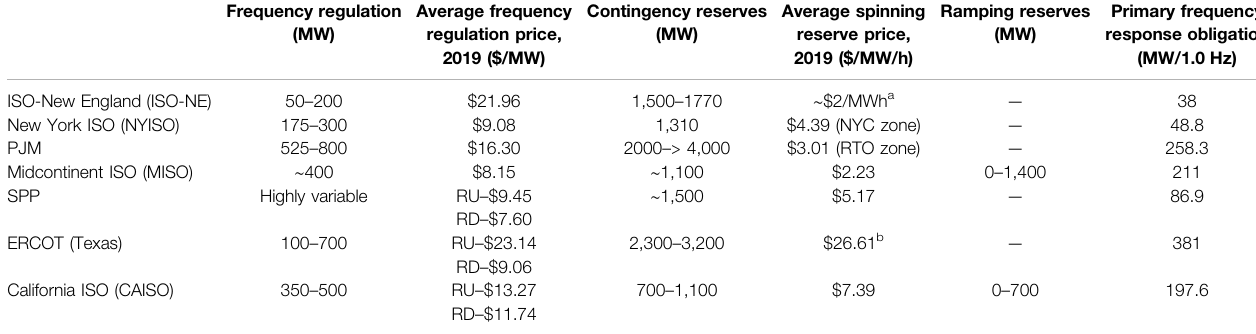
TABLE 4 | Ancillary service procurement quantities (MW) and selected prices ($/MW) and other obligations in U.S. ISOs, recent